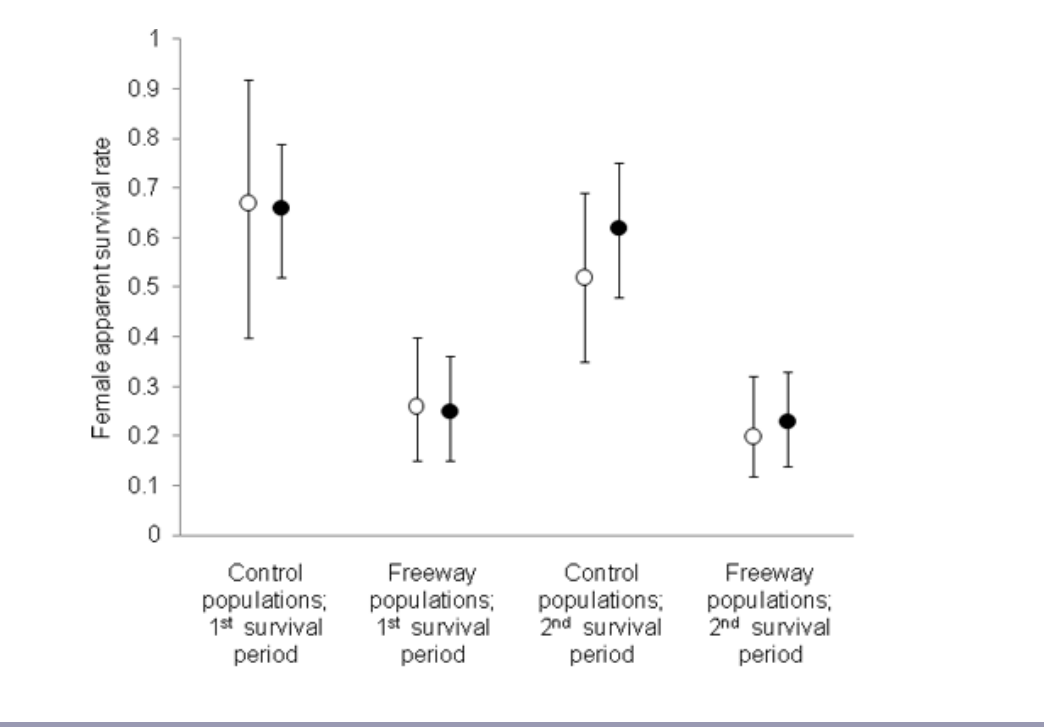
Fig. 3 . Apparent annual survival rate of female squirrel gliders ( Petaurus norfolcensis ) in control and freeway populations. Open circles are mean estimates with vague priors; shaded circles are estimates with informative priors. Bars are 95% credible intervals. Survival period refers to either of two time intervals over which apparent survival rates were estimated. The first survival period includes trap sessions between August 2005 and December 2006; the second includes sessions between January 2007 and February